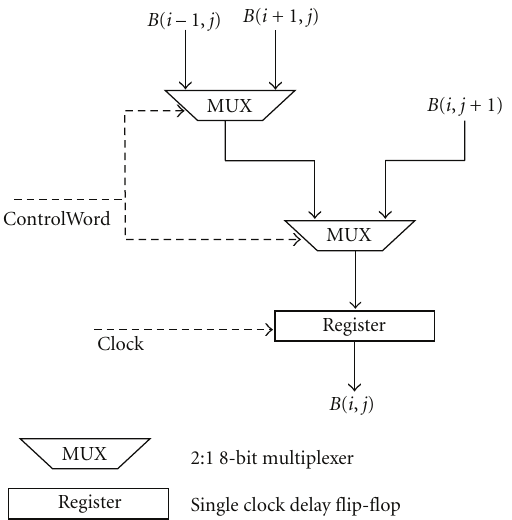
Figure 9: Inner design of B ( i , j ) node in 2-D CRA. ControlWord is derived based on the data flow during a given control step.